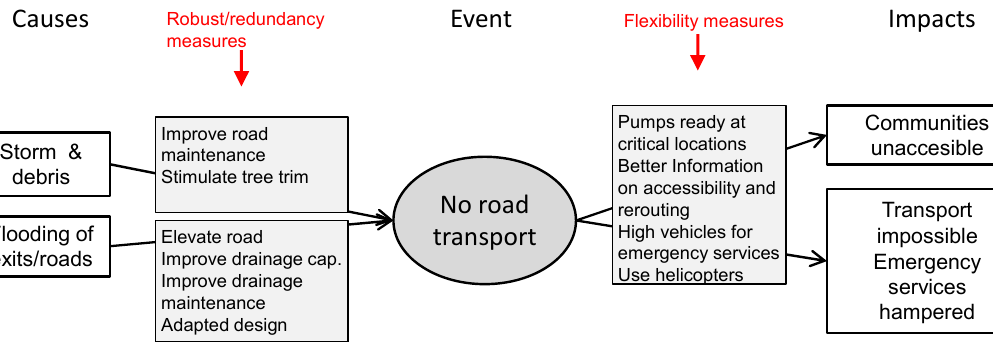
Figure 9. Road transport: causes, impacts, and potential measures which prevent disruption of road transport (in the grey blocks on the left side) or mitigate impacts (grey blocks on the right side).